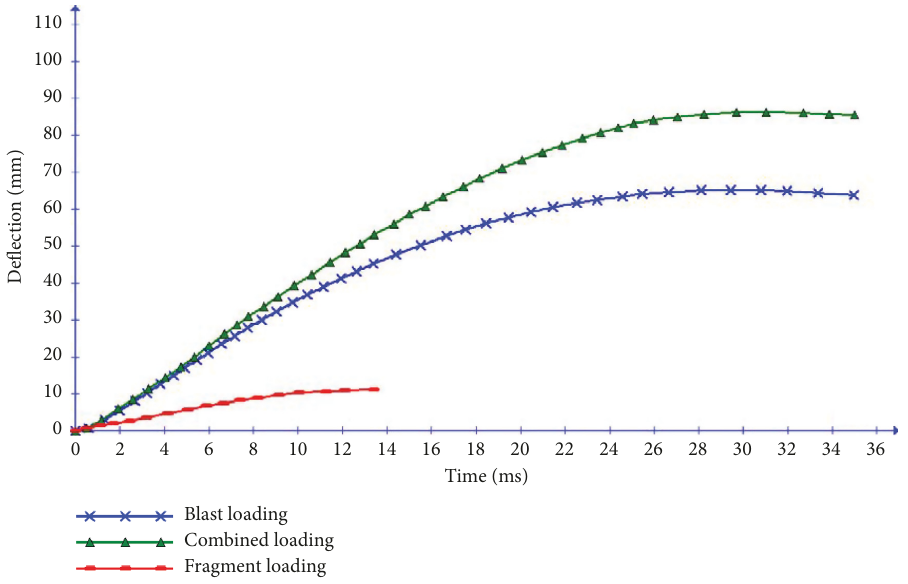
Figure 12: Displacement-time history plot for RC wall for different load cases